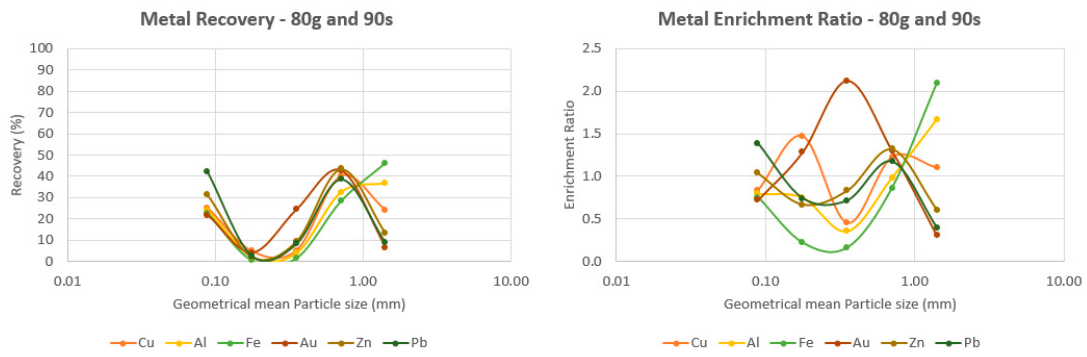
Figure 11. ( a ) Metal recovery and ( b ) Metal enrichment ratio after hammer milling as a function of feed mass, milling time and particle size. Feed particle size fraction was 1–2 mm. The feed mass was 80 g and milling time was 90 s. Experimental data points are connected with lines for the purpose of visual aid only.